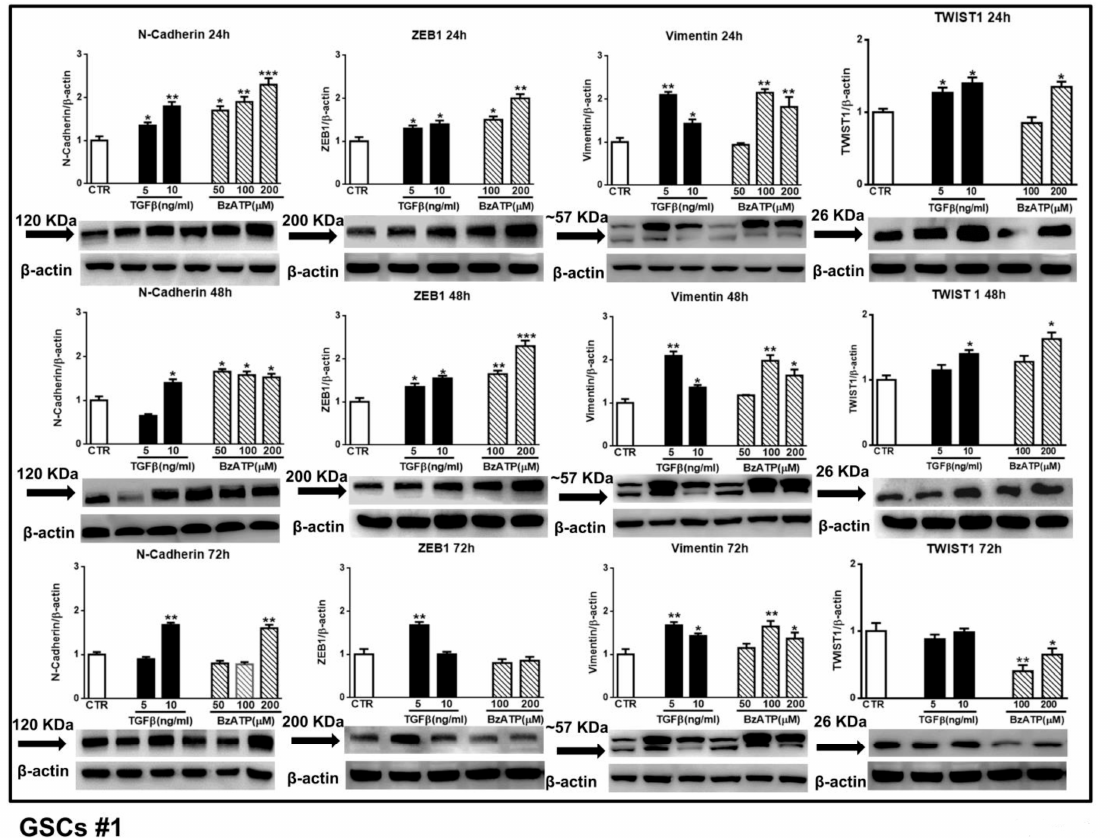
Figure 4. E ff ect of TGF β 1 or BzATP on EMT markers evaluated by western blot analysis at di ff erent times after drug administration to cultured GSCs. GSCs #1 were exposed to di ff erent concentrations of TGF β 1 or BzATP and harvested at the indicated times. The protein levels of EMT markers were determined by western blot analysis. Over the arrows close to the immune-bands the molecular weight (MW) of each EMT marker is reported according to the MW indicated in the data sheet of the used antibody. To note that for vimentin, which showed a double immune-band, as also reported in literature [35], the molecular weight is equal to about (~) 57 KDa to indicate an average of the weights of the two bands. Immunoblots were re-probed with an antibody against β actin, quantified by densitometric analysis, normalized to β actin used as an internal control, and reported in the histograms assuming the value of control / β -actin = 1. Immunobands in the figure are representative of three independent experiments. Of note, β -actin bands are the same for some blots reported in the figure, since they were obtained by cutting the same membrane at di ff erent heights corresponding to the molecular weights of the selected markers. * p < 0.05, ** p < 0.01, *** p < 0.001: statistical significance vs. untreated GSCs assumed as control (CTR) (one-way ANOVA plus Dunnett’s